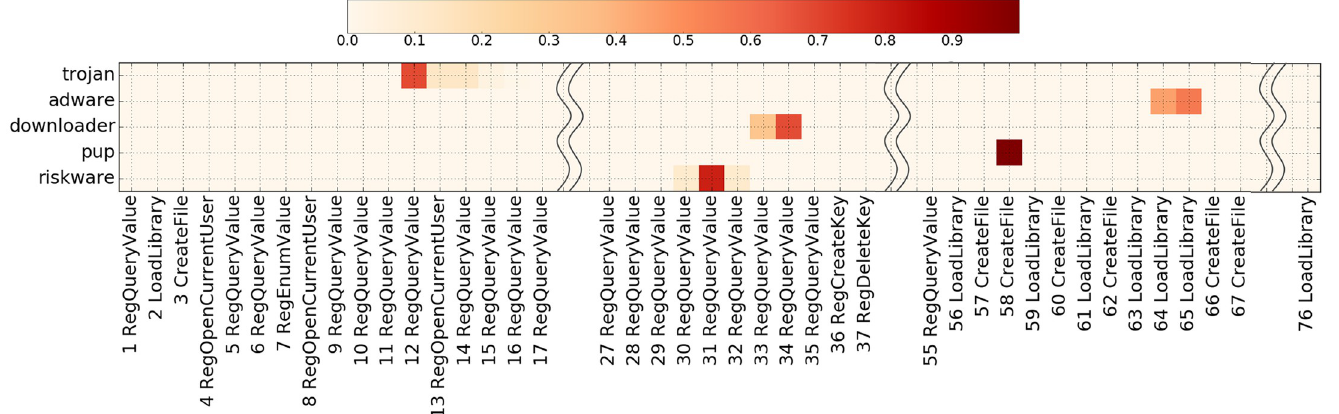
PLOS ONE | https://doi.org/10.1371/journal.pone.0263644 May 16,